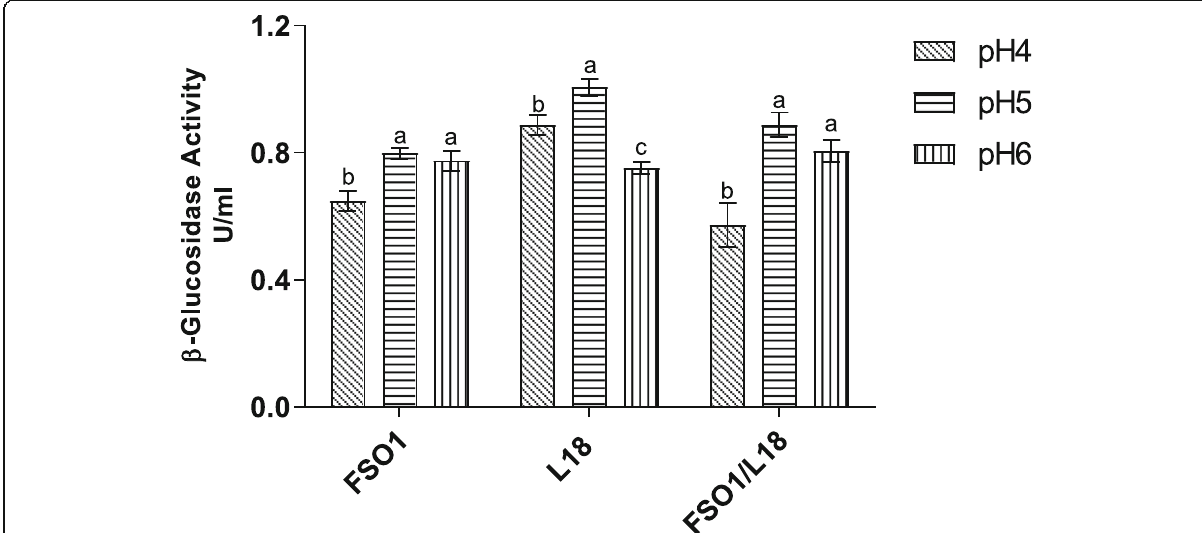
Fig. 10 Residual activity of β -glucosidase after 7 days of cultures at 30 °C for pure (FSO1, L18) and combined (FSO1/L18) cultures in modified